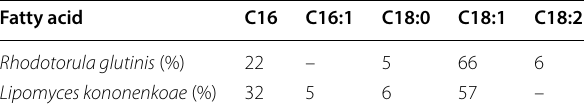
Table 7 Relative mass percentage of fatty acid present in the lipid extract of Rhodoturula glutini s and Lipomyces kononenkoae after extraction using the optimum conditions of extraction